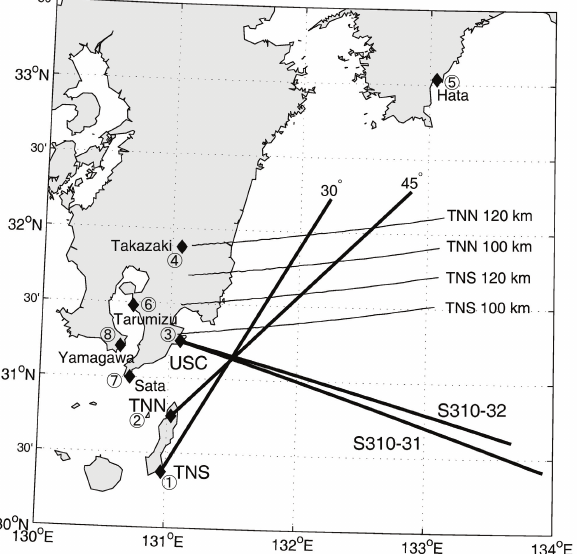
Fig. 2. Observation area of SEEK-2. Trajectories of the sound- ing rockets S-310-31 and S-310-32 are shown by the curves from USC (Uchinoura Space Center, ISAS/JAXA). Two portable radars were located at TNN (Tanegashima-north) and TNS (Tanegashima- south) sites, and they observed E-region FAI echoes with azimuth angles of 30 ◦ and 45 ◦ , respectively. Instruments located at the ground sites (1–8) are listed in Table 1.